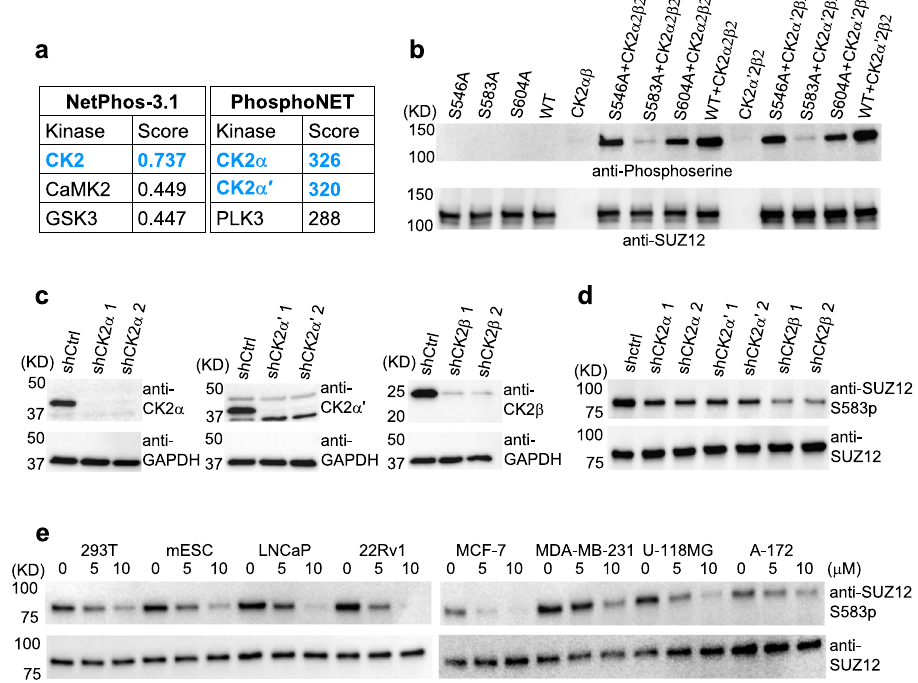
Fig. 2 | CK2 is the kinase for the phosphorylation of S583 of SUZ12. a Kinase predictionbywebserversNetPhos3.1andPhosphoNET.Thepeptidemotifaround S583wasusedfortheprediction.ThetopthreehitsarelistedineachcasewithCK2 highlighted in blue. b In vitro phosphorylation assay. CK2 complexes were expressed in HEK293T cells and GST-tagged full-length SUZ12 WT and mutants were expressed in bacteria.Totalserine phosphorylationwasmeasured by ananti- phosphoserine antibody (uncropped gel images of this fi gure are shown in Sup- plementary Figs. 16 and 17). A representative of three independent experiments is